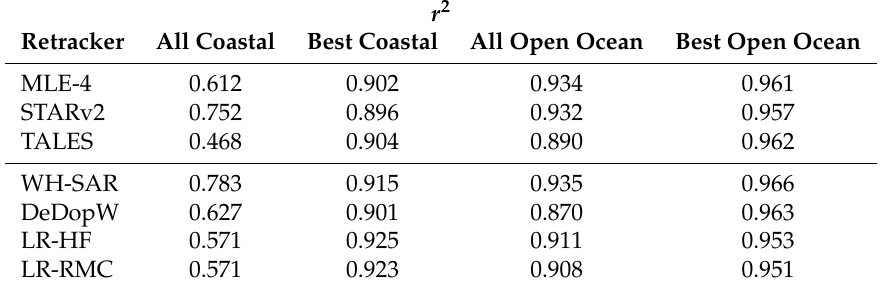
Table 3. The results for the different retrackers applied to Sentinel-3A data showing the effect of different buoy selection criteria. In all cases, a minimum of 20 valid SWH measurements along track is required. The SAMOSA retracker is omitted here because of uncertainty about the implementation of its quality flag. r